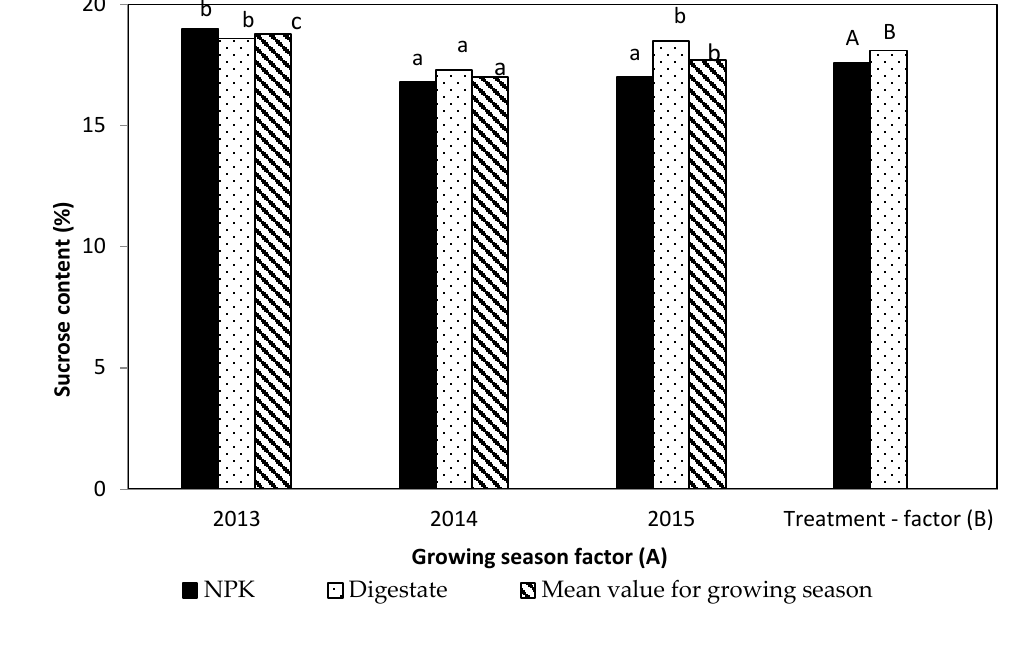
Figure 6. Effects of growing seasons and fertilization treatments on content of dry matter in sugar beet roots.